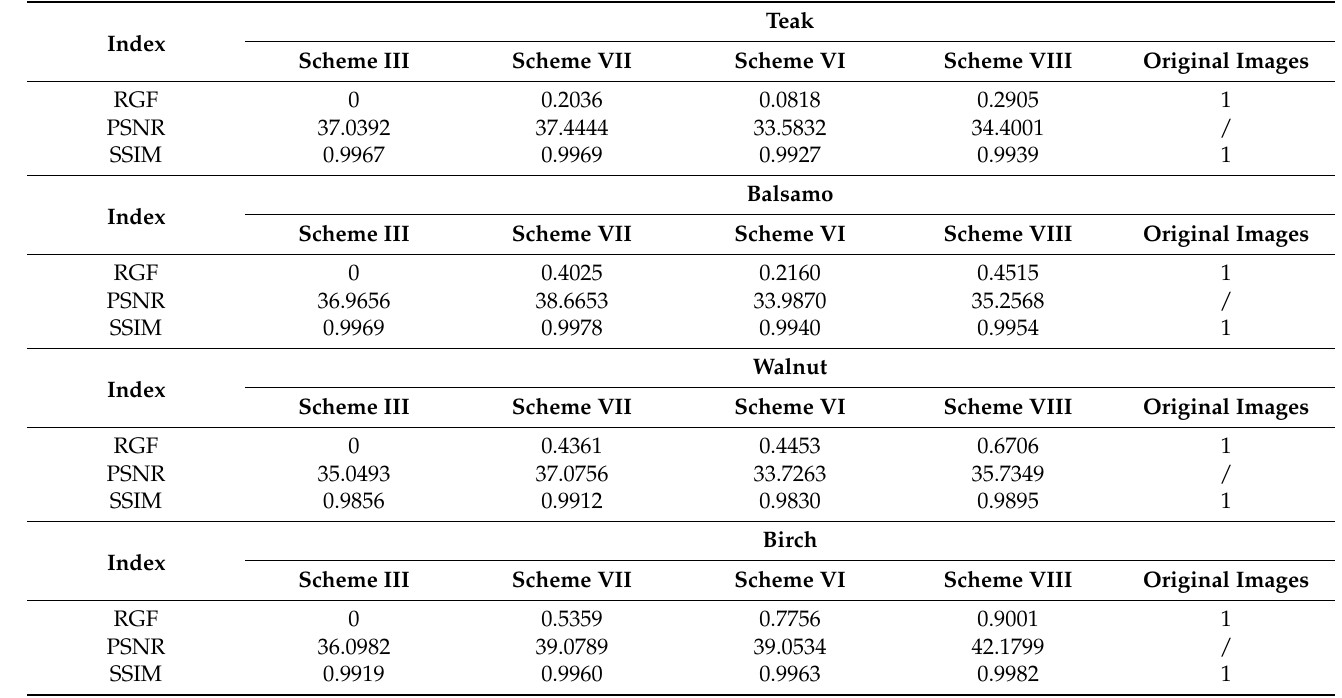
Table 4. RGF, PSNR, and SSIM values of the four kinds of